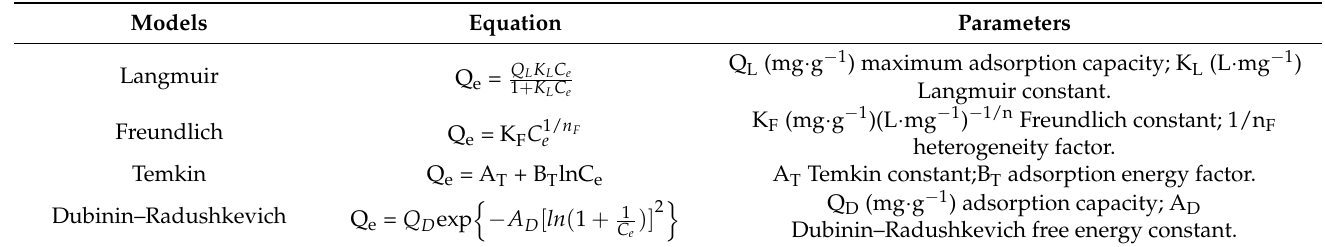
Table 2. Equations of the isotherm models used in this